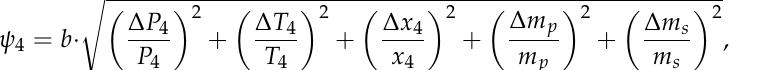
Table 1. Cont. Parameter Measurement Calculation Error Exergy E , W Exergy efficiency ε ex